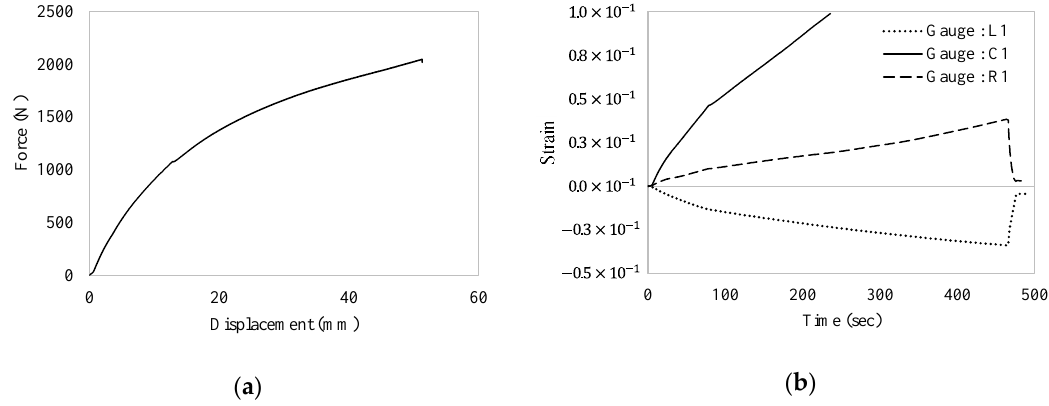
Figure 12. ( a ) Force–displacement relationship obtained from a load tester, and ( b ) strain changes over time obtained from strain gauges.